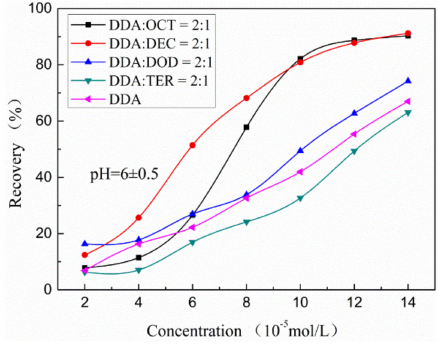
Figure 2. Muscovite recovery as a function of mixed collector